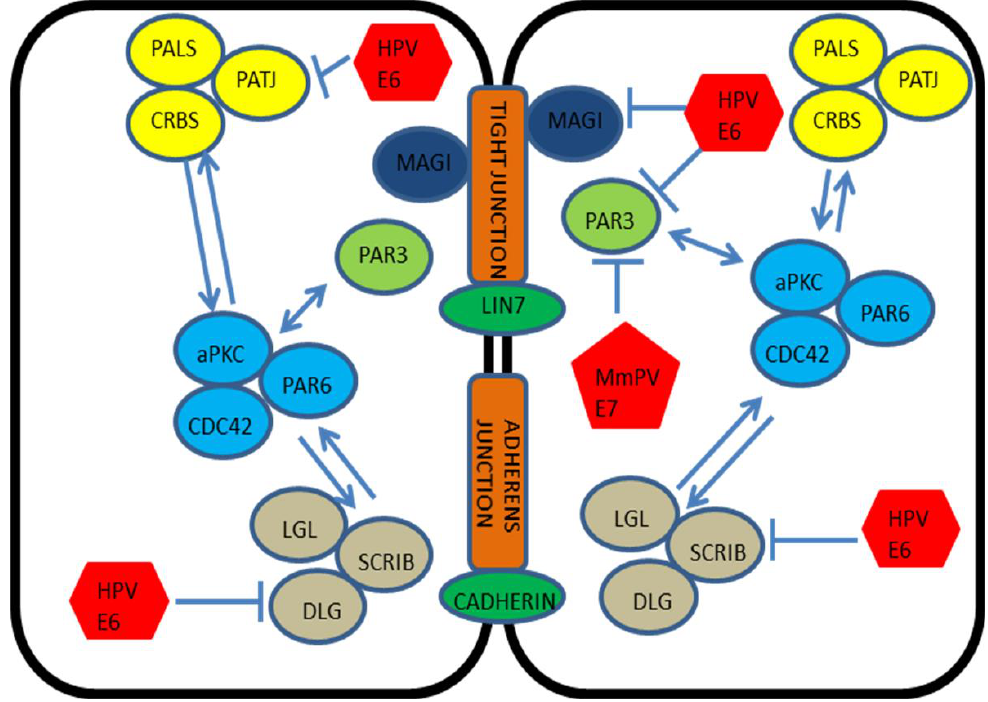
Figure 3. Papillomavirus oncoprotein targeting of cell polarity proteins. The cartoon depicts the various proteins comprising the three major complexes that regulate cell polarity: apical is defined by the Crumbs (CRBS) complex, subapical by the Par complex and basolateral by the Scrib complex. These complexes interact through a series of mutually antagonistic interactions ensuring correct spatial distribution and levels of expression of the individual components. Note the propensity of HPV E6 and MmPV E7 to target diverse components of this cell polarity control network, thereby perturbing their levels of expression or subcellular distribution.